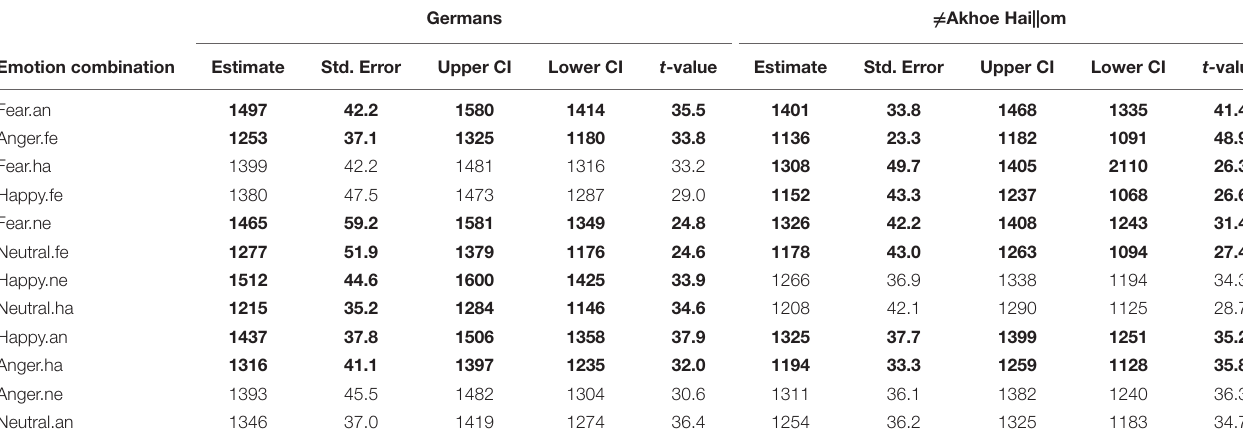
TABLE 2 | Estimates for the mean fixation duration (in ms) on a target emotion vs. a specific distractor emotion (see also Figure 2 ) for both groups.